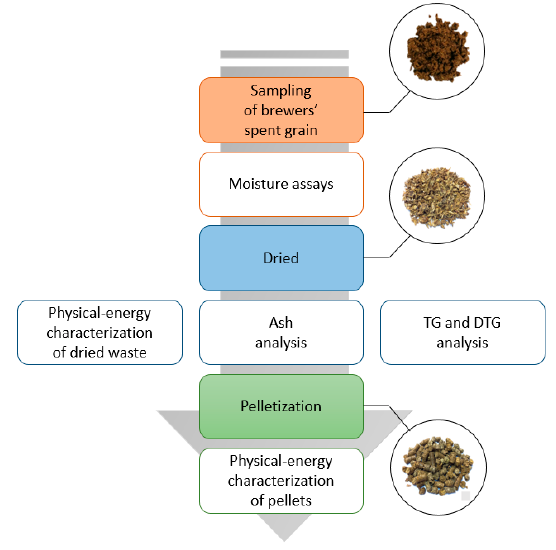
Figure 1. Main stages of the research carried out.